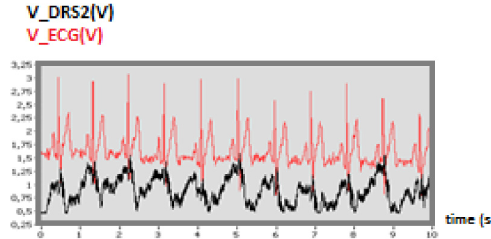
Figure 8. The evolution of the DRS2 and ECG voltage signals, after analogue and digital signal processing.